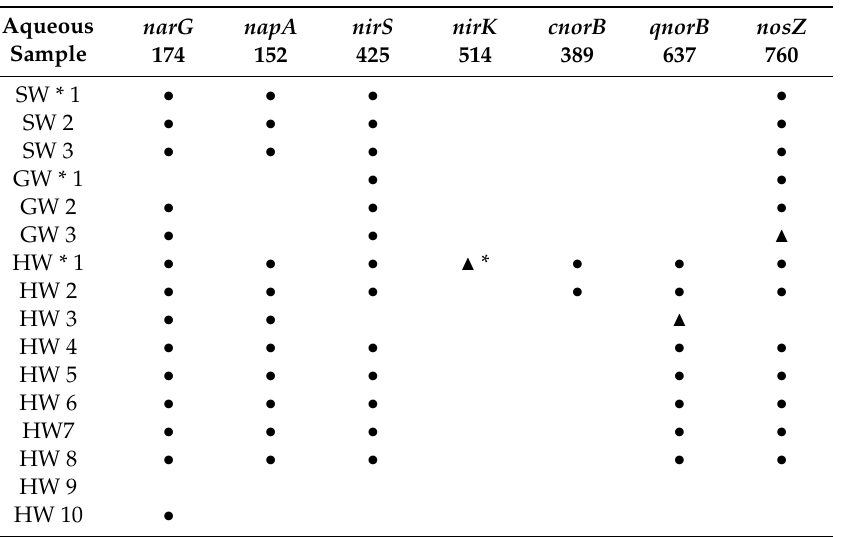
Table 3. PCR primer set validation of denitrification-associated genes using sixteen aqueous environmental